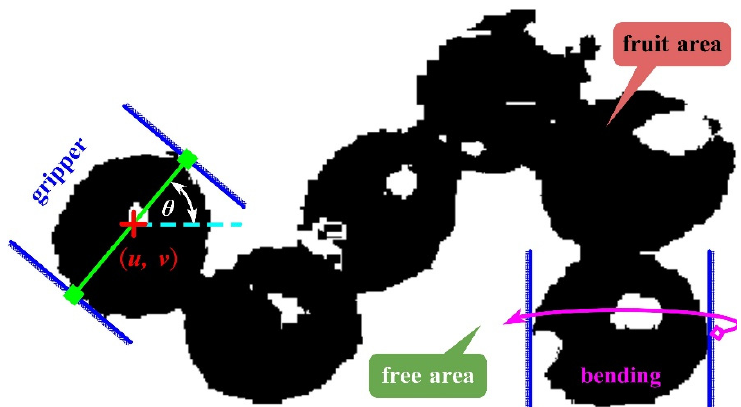
Figure 3. Schematic diagram of grasping-angle definition.